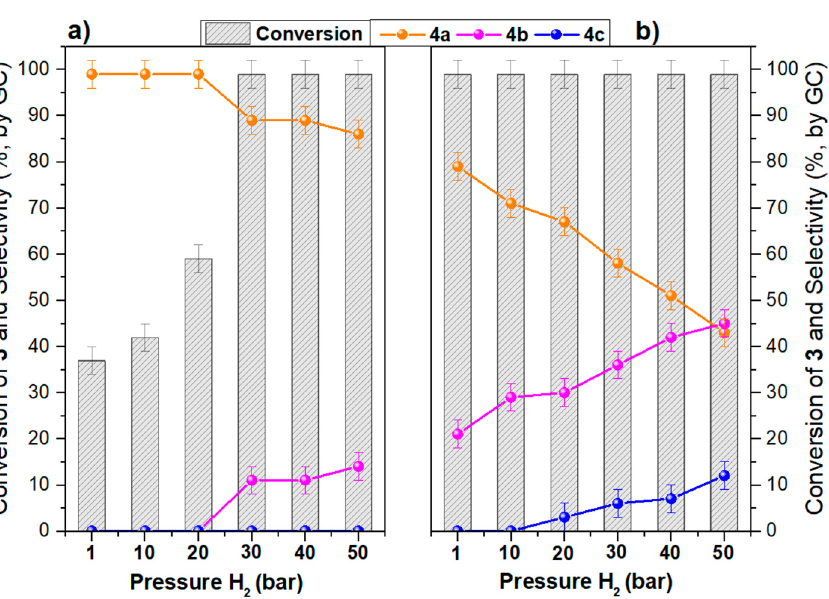
Figure 8. Effect of pressure in the reductive amination of furfural at ( a ) 25 °C and ( b ) 100 °C. Reaction conditions: 3 (0.1 M in methanol), Pd-N/C a (50 mg), flow rate (0.3 mL min − 1 ). Conversion and selectivity were determined by GC.